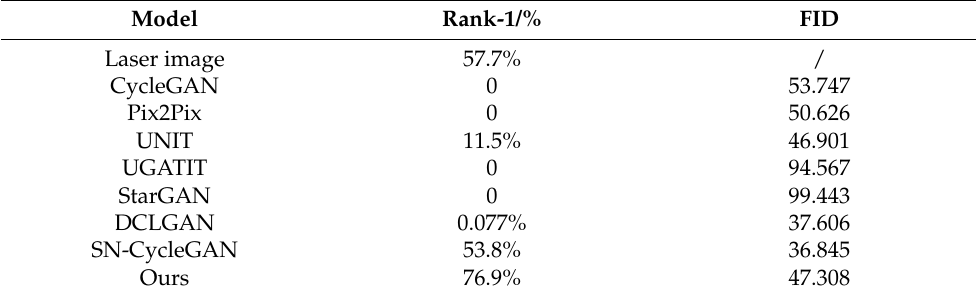
Table 6. Laser-visible face image recognition accuracy in